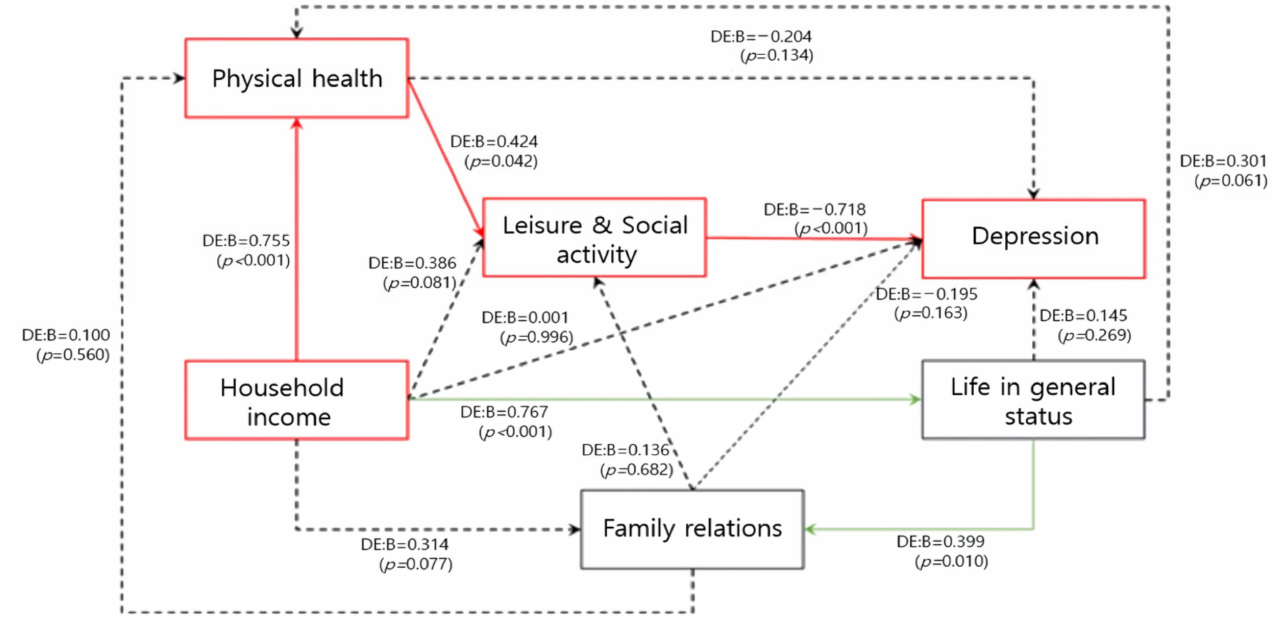
Figure 1. Pathway factors of caregiver’s depression. Red line: Mainly pathway factors of caregiver’s depression. Green line: Significant pathway, but no factors caregiver’s depression. Black dashed line: Not significantly pathway. DE: direct